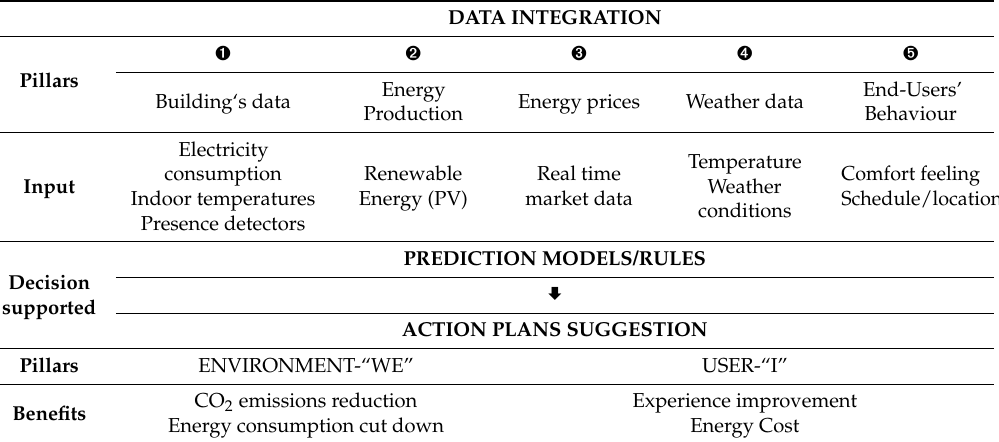
Table 1. Operating process.